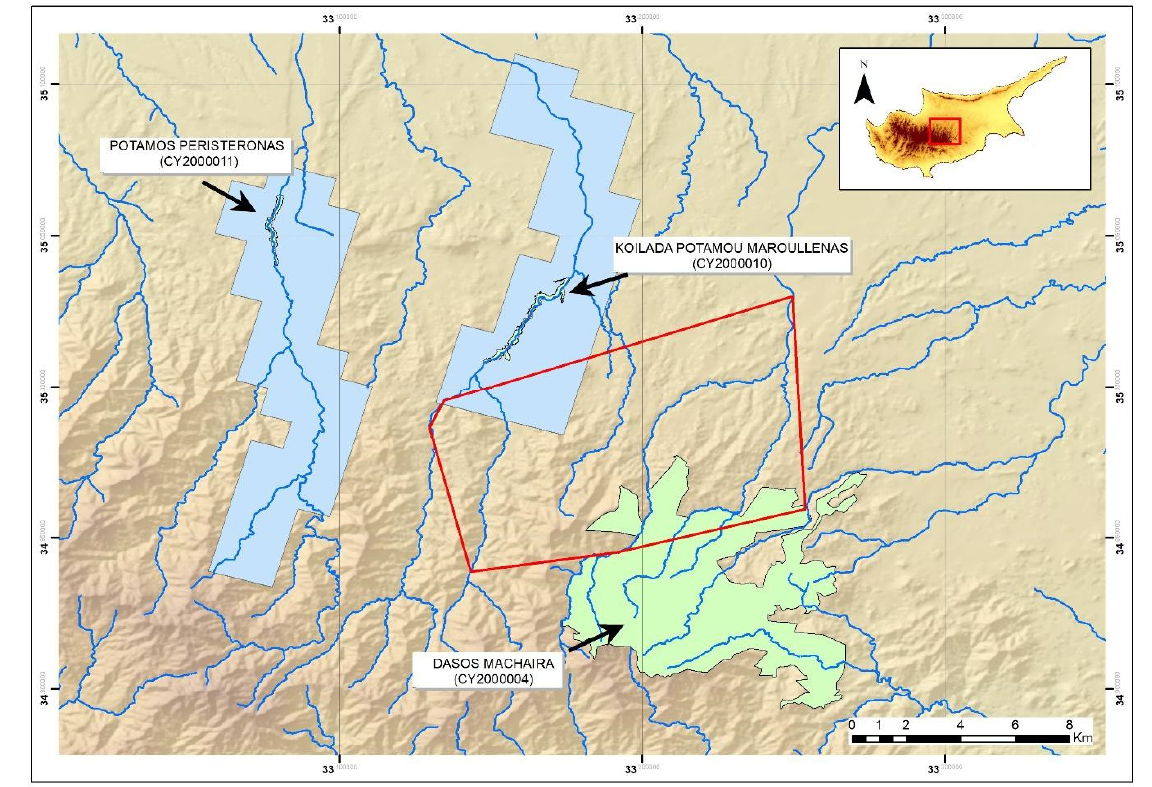
Figure 6. Map of the study site in the Troodos Mountains, indicating the currently known species distribution of N. n. cypriaca (blue polygon), the Natura 2000 sites in the area (green polygons named and indicated with arrows) and the minimum convex polygon extracted by the data of this research (red polygon). In total 12 of the 13 new sightings of the species provided by this research were outside of its known distribution, while three of the sightings were within a Natura 2000 area (Dasos Machaira) not currently designated for the species.